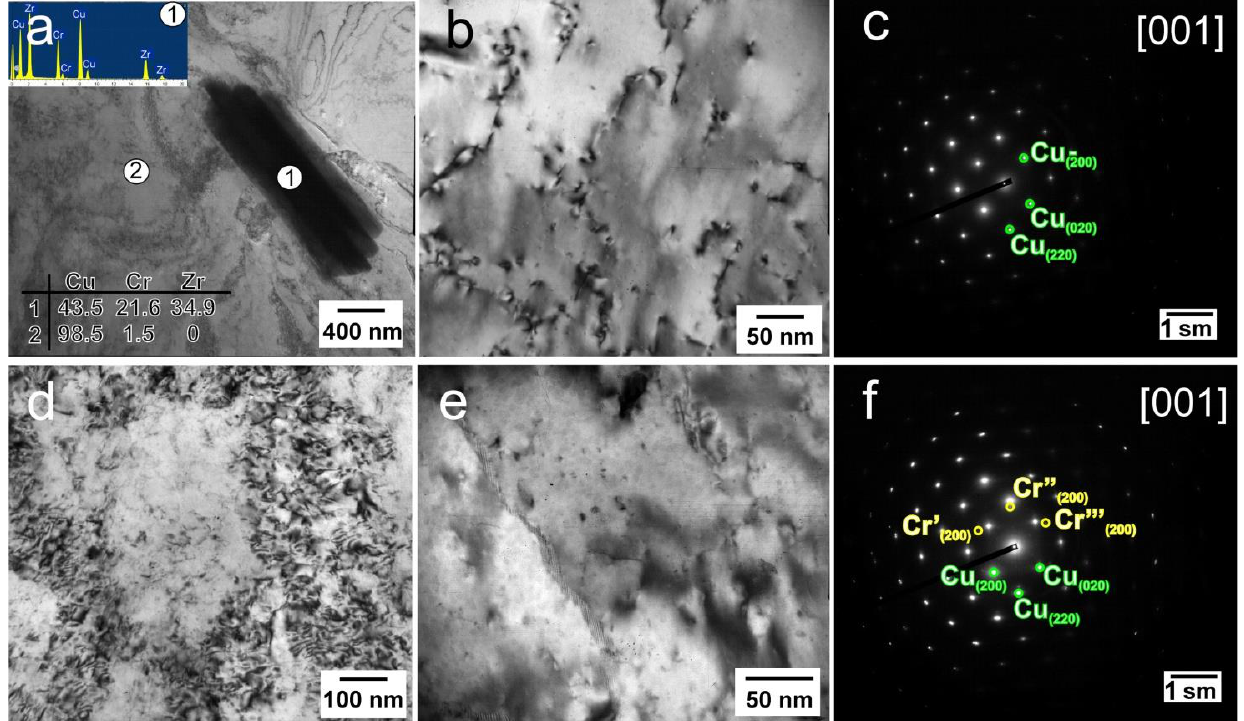
Figure 3. Fine structure of the Cu-0.5%Cr-0.08%Zr alloy in various states (( a ) extrusion + RS; ( b ) extrusion + quenching + RS; ( c ) SAED pattern with [001] zone axis for alloy after extrusion + quenching + RS; ( d , e ) extrusion + RS, ( f ) SAED pattern with [001] zone axis for alloy after extrusion + RS ). Figure 4 shows the results of studying the aging processes in the Cu-0.5%Cr-0.08%Zr alloy before and after rotary swaging by studying the dependences of microhardness and electrical conductivity on temperature (Figure 4a,b) and time